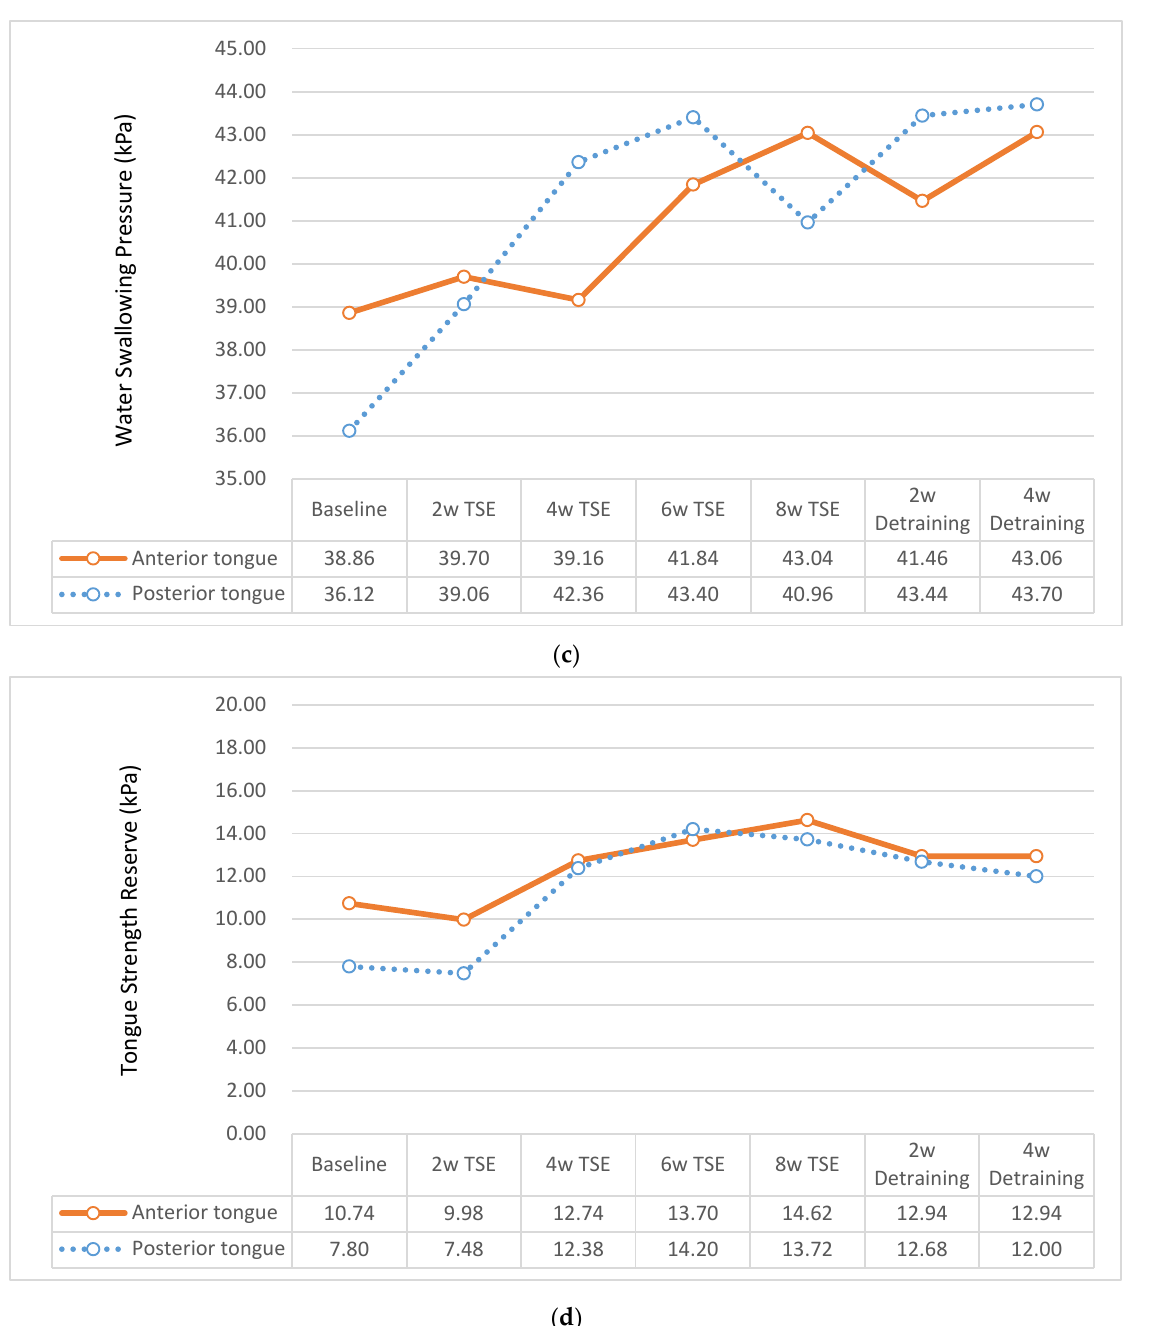
Figure 3. Detraining effects of the tongue strength by location of the tongue: ( a ) maximum isometric pressure (MIP), ( b ) saliva swallowing pressure, ( c ) water (5 mL) swallowing pressure, and ( d ) tongue strength reserve. 2w: 2 weeks; 4w: 4 weeks; 6w: 6 weeks; 8w: 8 weeks; TSE: tongue-strengthening exercises.